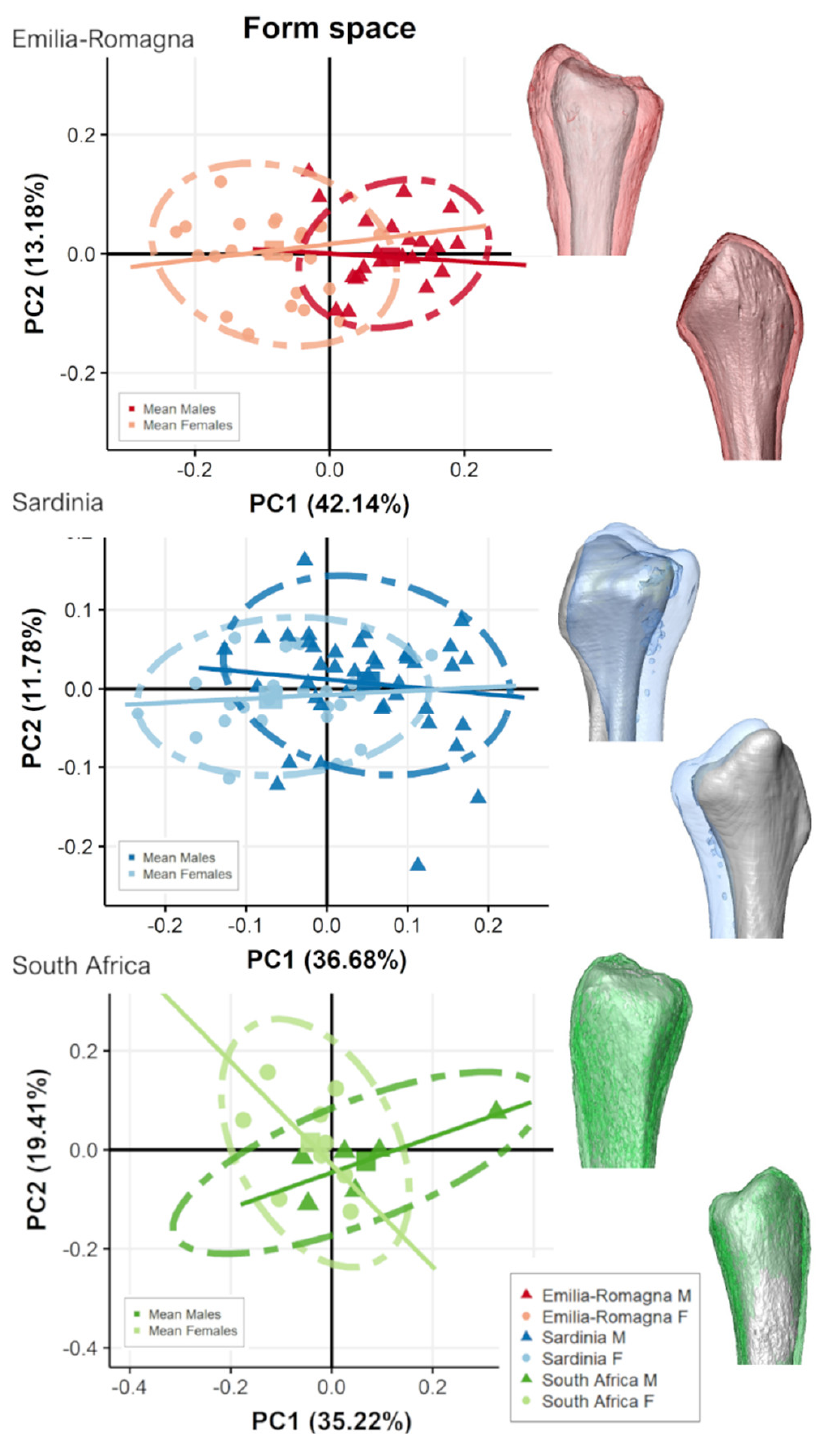
Figure 7. Scatterplot of form-space PC scores of proximal fibular epiphyses for the two Italian and the South African populations, divided by sex groups and presenting mean male (colored) and female (grey) form variation along the PC axes, represented in the scatterplot as squared dots, in medial ( top ) and lateral ( bottom ) views. Lines represent allometric trajectories for males and females for each population.